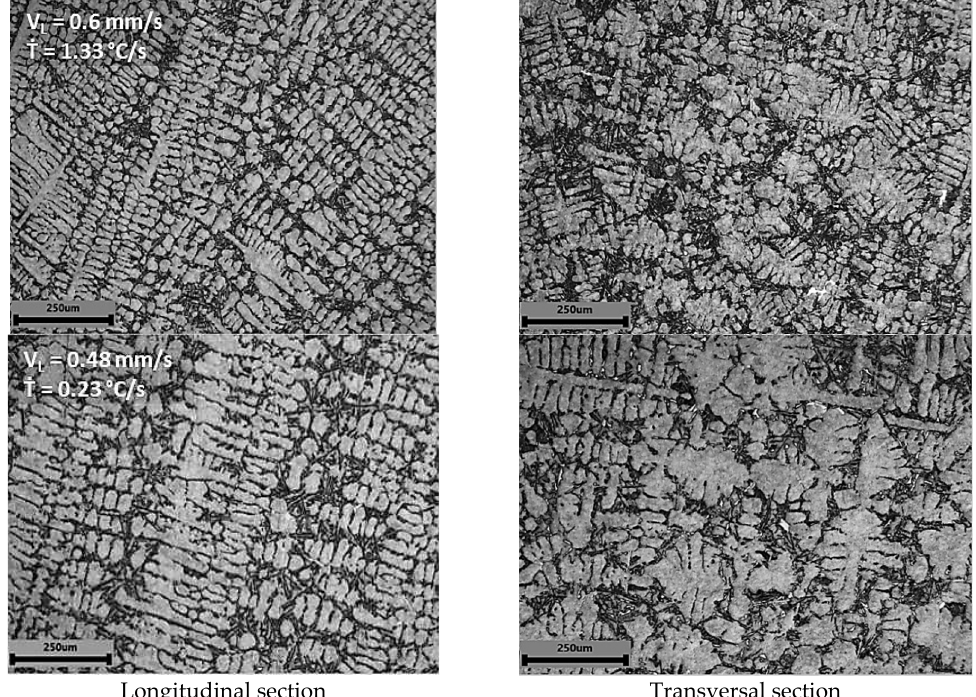
Figure 6. Light microstructures showing dendritic arrangements and their dependencies with cooling rates and growth velocities for the Al-10 wt.% Si-1 wt.% Mg alloy.